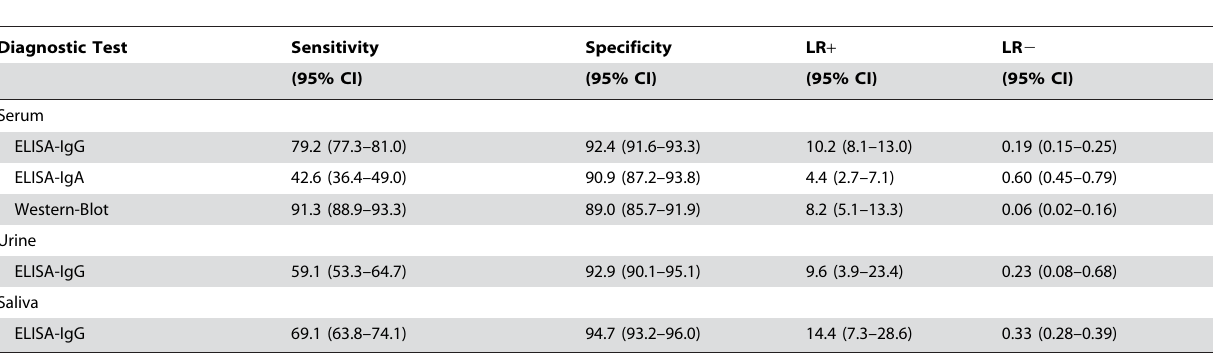
Table 2. Summary measures of test accuracy from the studies